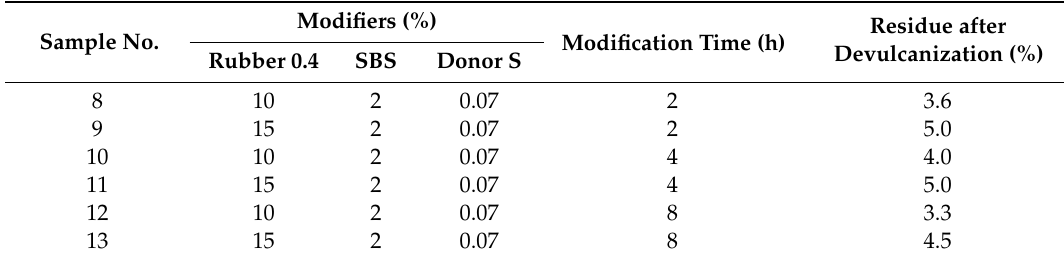
Table 2. Bitumen modified at 220 ◦ C.